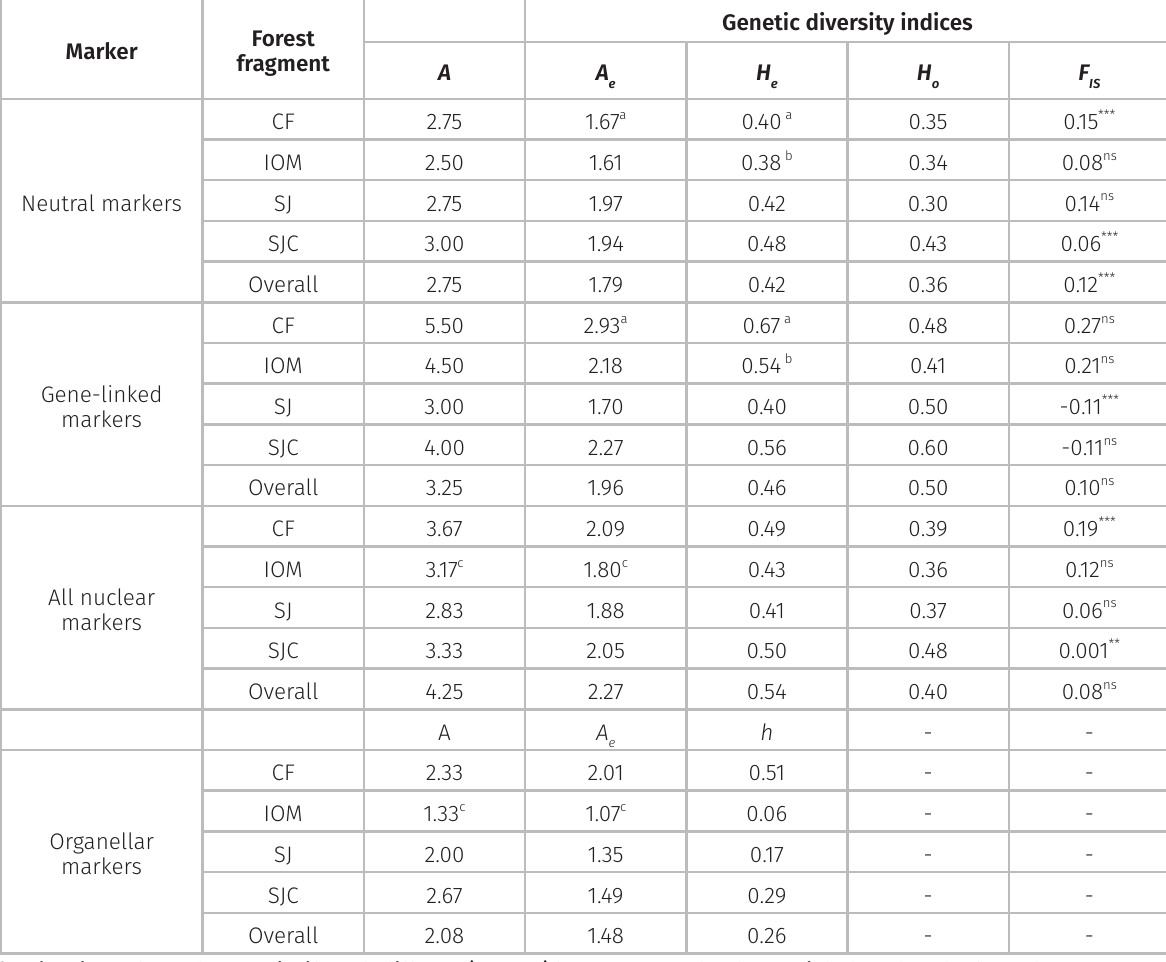
Table I. Genetic diversity indices at forest fragment level and overall fragments, for each microsatellite marker